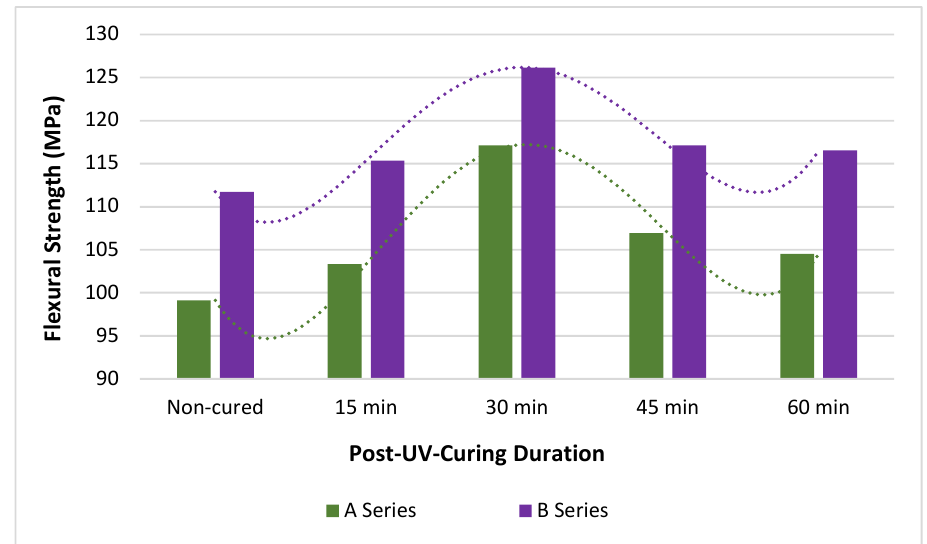
Figure 5. Flexural strength—post-UV curing duration graph of PLA parts.